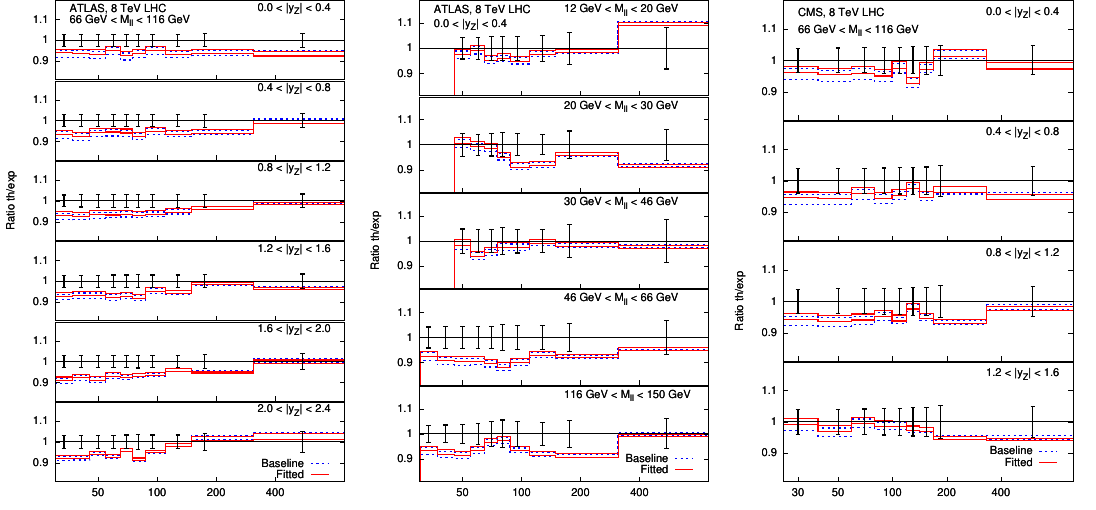
Figure 14 . p Z observables computed at NNLO with input PDFs before and after the addition of T the p Z data in the global T